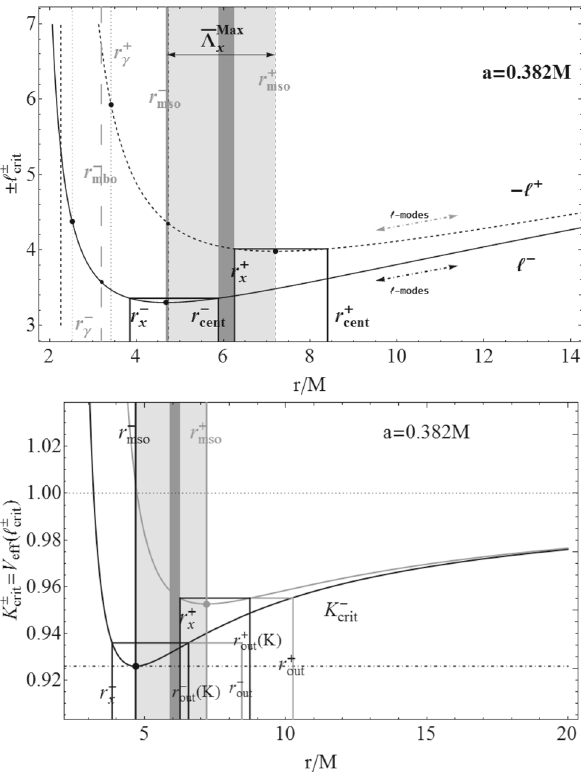
Fig. 5 (cid:4) -modes representation. Upper panel : fluid specific angular momenta ∓ (cid:4) ± for counterotating and corotating tori respectively, crit indicating the pressure extreme points, in the spacetime of a BH with spin a = 0 . 382 M as function of r / M . The RAD perturbation (cid:4) -modes reduces to shifts on the each curve (cid:4) ± . Tori centers, r ± cent , and accreting points r ± × of a tori couple C − × < C + × are shown (lines (cid:4) = constant), r ± γ are the photon circular orbits – see Figs. 2, 4, and 11 for related density surfaces. Light-gray region is the limiting maximum spacing of the two accreting tori in this spacetime, black continuum lines are the marginally stable orbits r ± mso , the gray region is the limiting, maximum spacing for the specific tori in the couple, for growing K (cid:4) -modes of the inner corotating tori – see also Figs. 12 and 13. Bottom panel : plot of K ± as function of r / M , inner edge r ± × and outer edges of accreting crit tori for a colliding couple are also shown, collision region is enlarged. Light-grayregionisthemaximumlimiting spacing forthetwoaccreting Fig. 4 GRHD -numerical 3D integration of tori density surfaces (solu- tori. each torus elongation on the equatorial plane is set by the K crit = tions of Eq. (7)). Colors are chosen according to improved visual constant lines. Gray shades the same region as in upper-panel. Note effects. Integration is stopped at the emerging of tori collision. Black that for an accreting torus plots K crit ( r ) do not directly locate the torus region is r < r + , r + is the outer horizon of the Black hole of spin center, neither can be easily related to the effects of (cid:4) or K -modes. For a = 0 . 385 M , gray region is the outer ergosurface. Top panel pictures non accreting(quiescent) tori, lines K crit ( r ) = constant locatethe inner two (cid:4) counterrotating tori C − × < C + × , the inner corotating torus and the edge of an accreting torus r × and the center r cent (in figure r out ( K ) ) outer counterrotating torus is accreting onto the central BH , accretion an (cid:4) corotating couple of tori with different angular momentum, see for flux is stopped during RAD integration. Center panel focuses on a dif- a throughout discussion and main applications [26]. Figures 11 and 6 ferent RAD view, tofocus on theregion closetothe BH andtocolliding for further details. Limiting values K − mso < K lim ≡ 1 are region. Bottom panel shows a second collision phase when the matter flow from the outer counterrotating torus impacts on the inner corotat- ing accreting torus. Tori, centered on the BH , are coplanar and orbiting on the equatorial plane of the central Kerr BH . The entire SMBH-RAD system is tilted relative to the observer ± ( a ; r , (cid:4)) locate the tori cen- in Figs. 6 and 11. Curves K crit